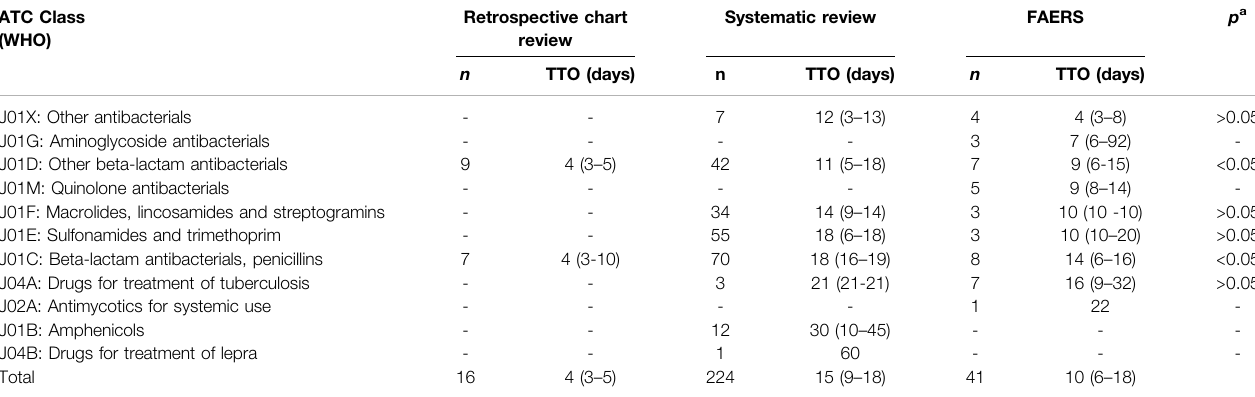
TABLE 3 | Comparisons of TTO analyses among fi ndings from pharmacovigilance study, clinical observation and literature. ATC Class